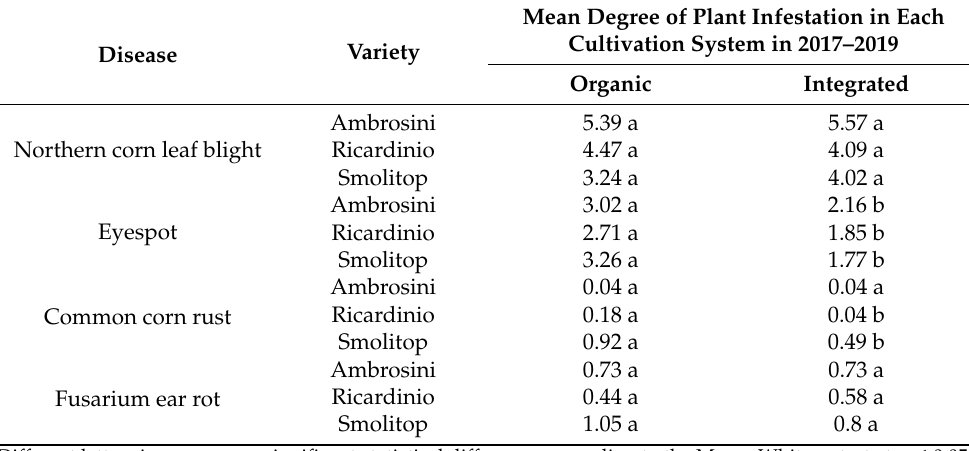
Table 5. The infestation of maize varieties depending on the cultivation system in the years 2017–2019.